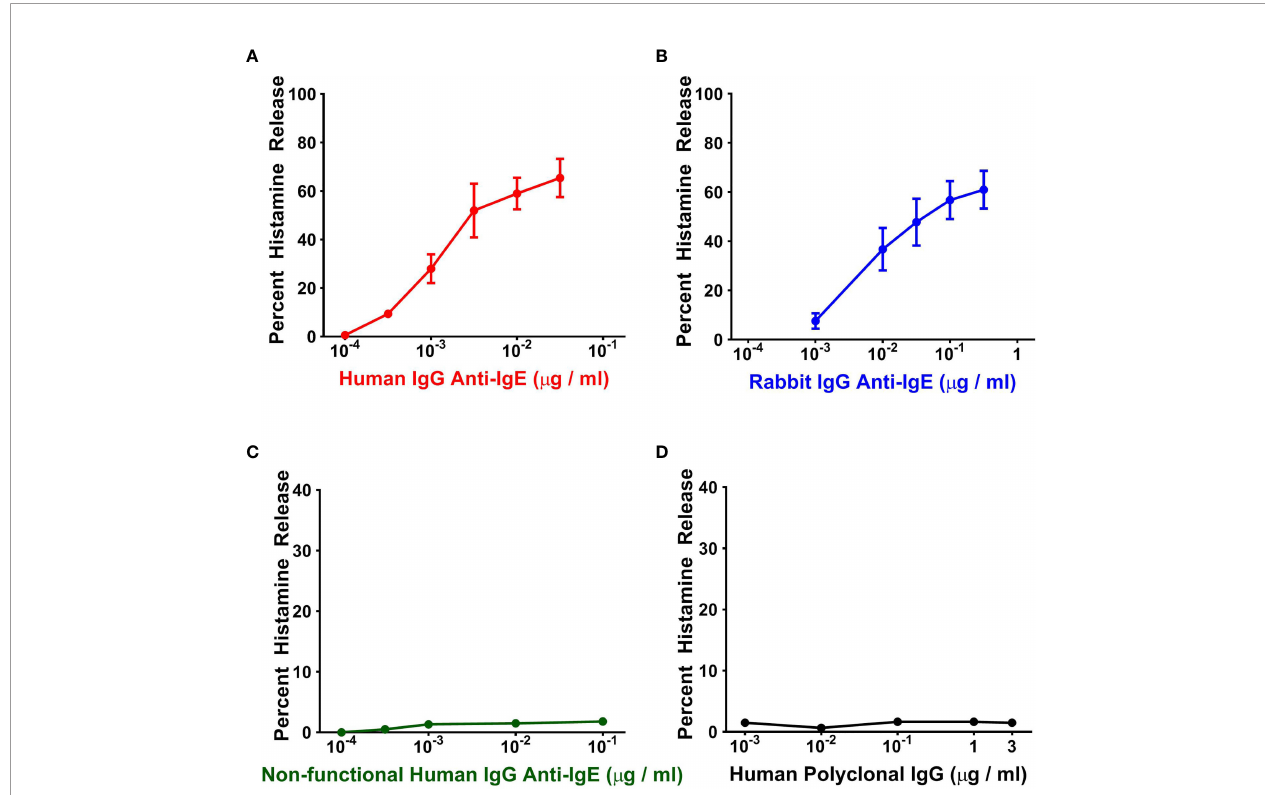
FIGURE 1 | Effects of increasing concentrations of human IgG anti-IgE (A) and rabbit IgG anti-IgE (B) on HR from basophils obtained from six normal donors. Neither non-functional human IgG anti-IgE obtained from the other fi ve atopic dermatitis donors (C) nor human polyclonal, pooled from six nonatopic donors, IgG induced mediator release from basophils (D) . Each point represents the mean ± SEM percent HR in six different preparations of basophils. Error bars are not shown when graphically too